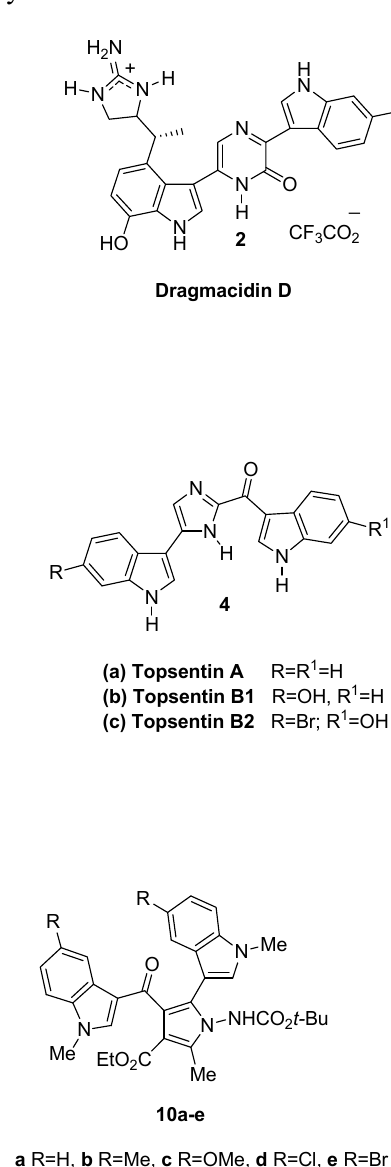
Figure 1. Bis-indolyl